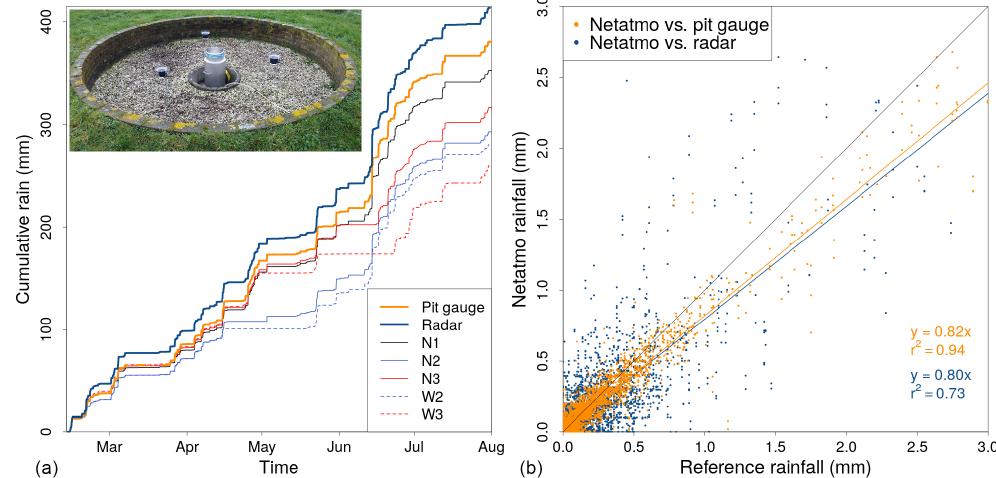
Figure 3. (a) Cumulative rainfall according to reference pit gauge, gauge-adjusted radar, Netatmo stations (N1, N2 and N3) and Netatmo stations obtained via WunderMap (W2 and W3). N2 (and, as a consequence, W2) was offline between 20 April and 1 May. The photo shows the experimental setup of the rain gauges in the pit gauge configuration. (b) Scatter plots of 10min rainfall and linear fits of rainfall according to N1, N2 and N3 as compared to reference pit gauge (orange) and gauge-adjusted radar